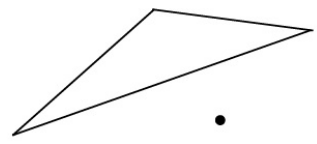
Figure 13: New point appears outside.